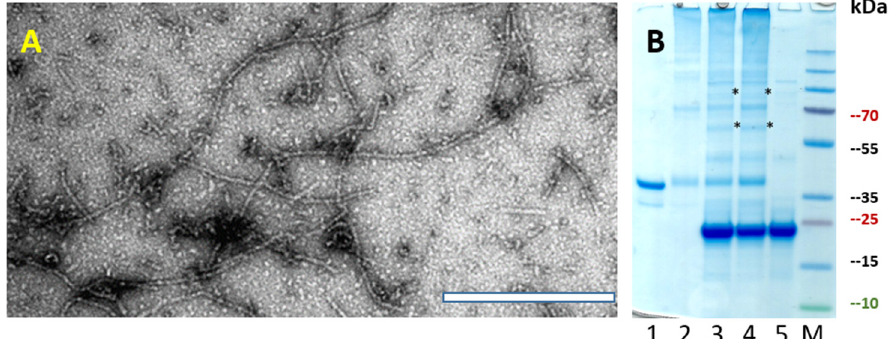
Figure 5. Chemically coupled PVY–Fel d 1 analysis. ( A ) Electron micrographs of negatively